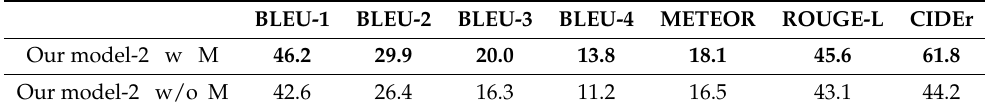
Table 3. Verification of the effectiveness of the newly proposed loss. “w M” denotes the model with the MIC loss, and the “w/o M” denotes the model without the MIC loss. The results show that the model’s accuracy is significantly improved with the addition of the new loss. The bolded numbers in the table are the best